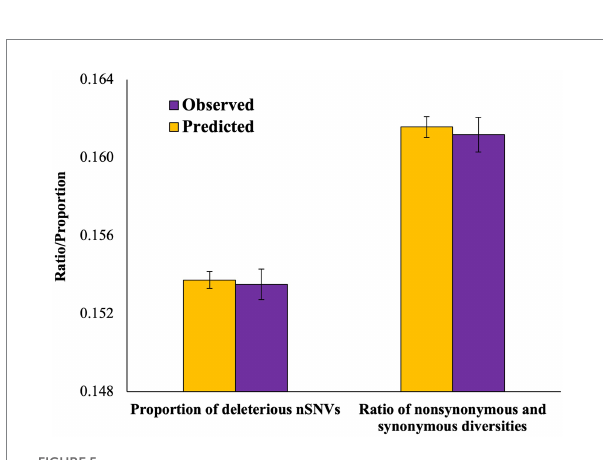
FIGURE 5 Column graph comparing the observed ( ω obs ) and predicted ( ω pre ) ratios of nonsynonymous and synonymous diversities and the proportion of deleterious SNVs observed ( δ obs ) and predicted ( δ pre ). The differences between the observed and predicted values of the ratios ( p = 0.33) and the proportions ( p = 0.32) were not statistically significant.